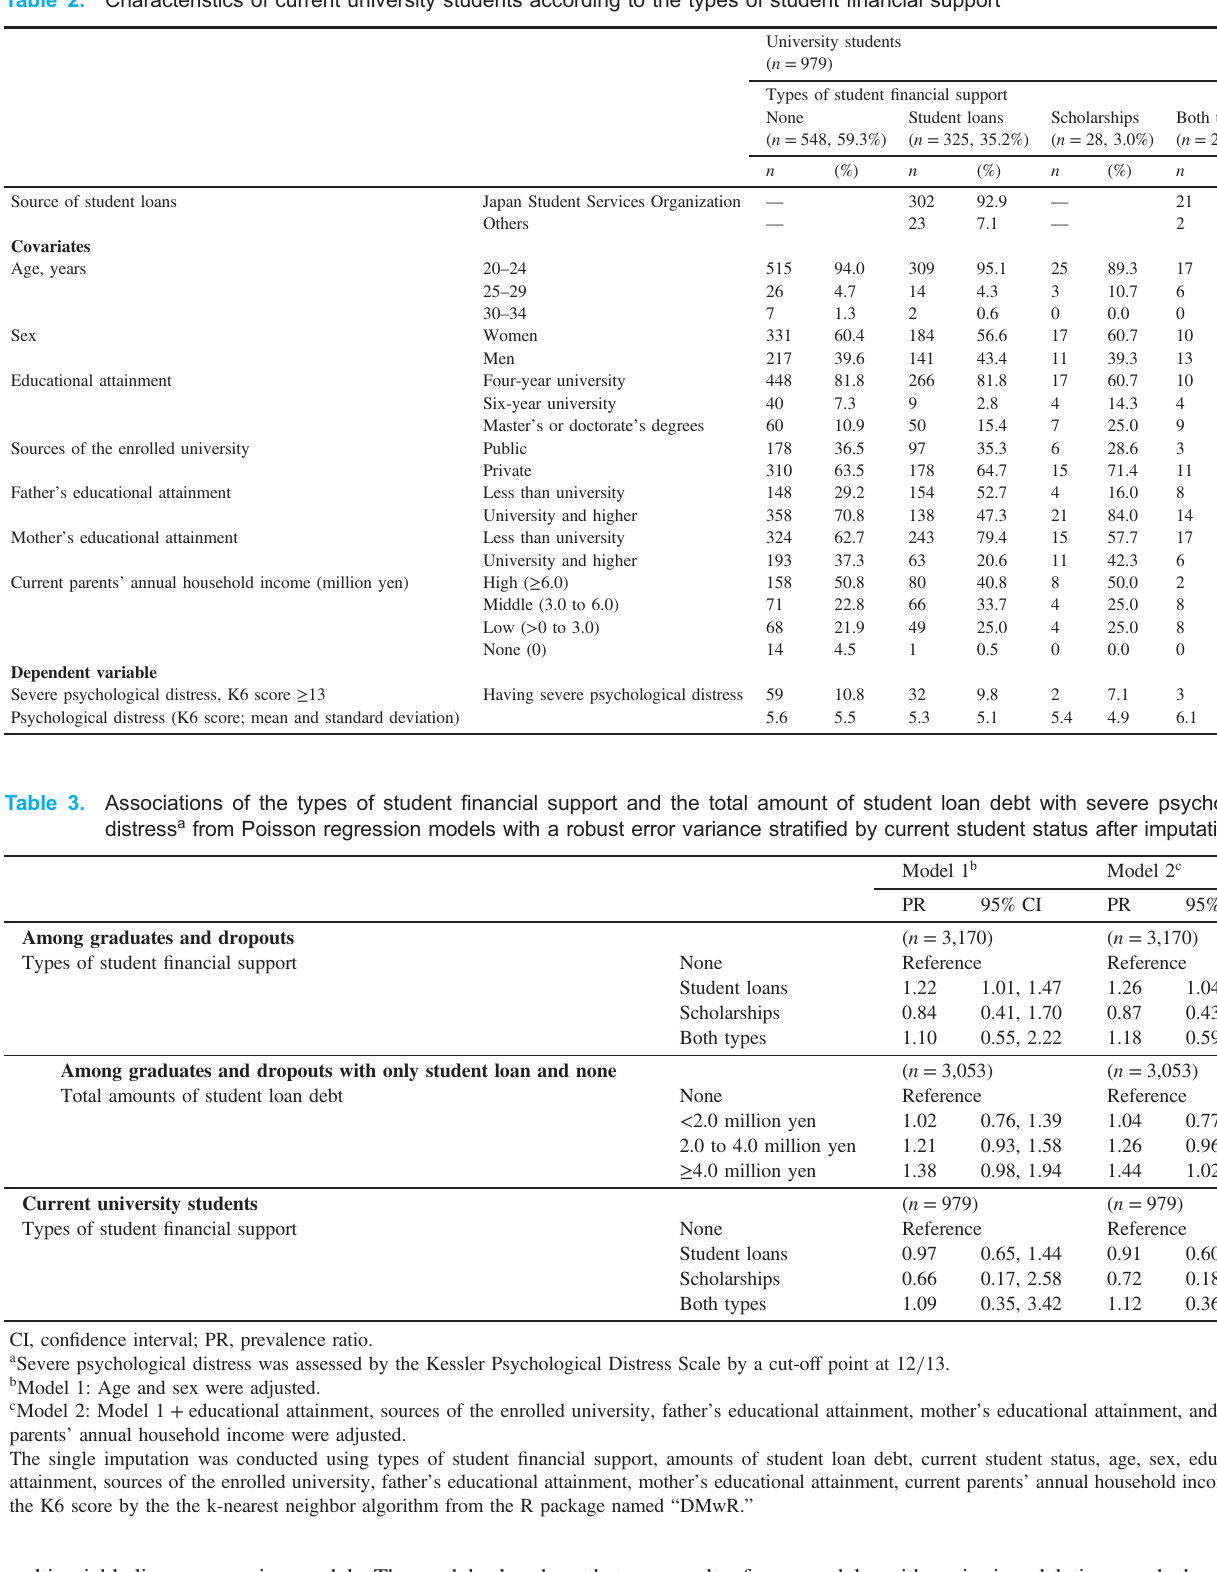
Table 2. Characteristics of current university students according to the types of student fi nancial support